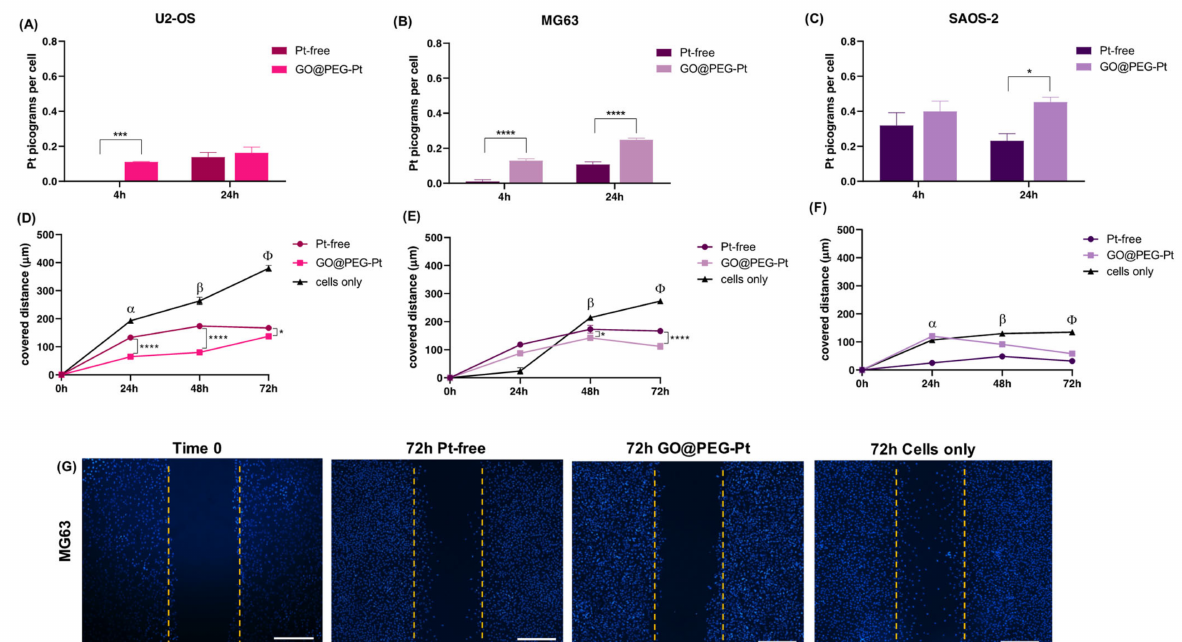
Figure 7. Human osteosarcoma cell lines: ICP-OES on U2-OS ( A ), MG63 ( B ) and SAOS-2 ( C ). Scratch test on U2-OS ( D ), MG63 ( E ) and SAOS-2 ( F ). α : Pt-free vs. cells only and GO@PEG-Pt vs. cells only, both p values ≤ 0.0001 in U2-OS; Pt-free vs. cells only. p value ≤ 0.0001 in SAOS-2. β : Pt-free vs. cells only and GO@PEG-Pt vs. cells only, both p values ≤ 0.0001 in U2-OS; Pt-free vs. cells only, p value ≤ 0.01, and GO@PEG-Pt vs. cells only, p value ≤ 0.0001 in MG63; Pt-free vs. cells only and GO@PEG-Pt vs. cells only, both p values ≤ 0.0001 in SAOS-2. ϕ : Pt-free vs. cells only and GO@PEG-Pt vs. cells only both, p value ≤ 0.0001 in U2-OS, MG63 and SAOS-2. Significant differences between Pt-free and GO@PEG-Pt are reported in the graph as follows: * p -value ≤ 0.05, *** p -value ≤ 0.001, **** p -value ≤ 0.0001. Representative DAPI staining of scratch test on MG63 cells ( G ) cells. Scale bars = 500 µ m. Cell nuclei are indicated in